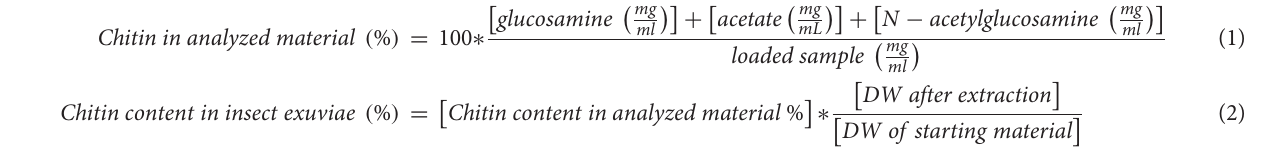
TABLE 1 | Insect materials used for chitin extraction. Insect species Body part/life stage Mealworm Larval exuviae Black soldier fly Larval exuviae House